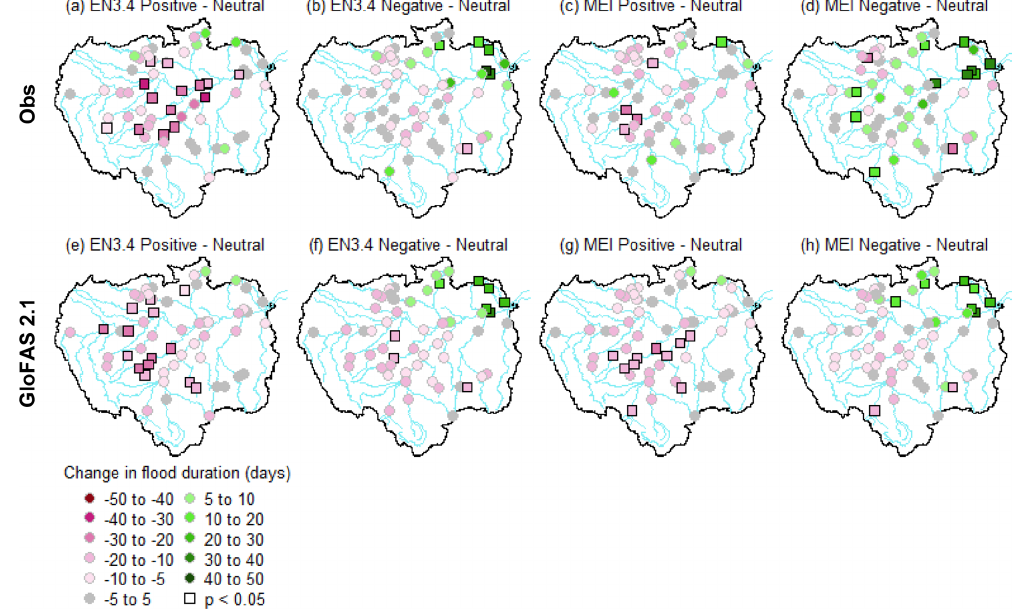
Figure 8. Changes in flood duration (i.e. mean number of days river flows exceed the 95th percentile of each station or grid point climatology) for different phases of the EN3.4 and MEI indices. (a, c, e, g) Positive with respect to neutral years. (b, d, f, h) Negative with respect to neutral years. Panels (a–d) represent changes for observations and panels (e–h) show changes for GloFAS 2.1 streamflow reanalysis data. Pink (green) points represent decreases (increases) in the number of days spent above the 95th percentile compared to neutral conditions. Significant results at the 95% confidence level are denoted using a square (i.e. p < 0 . 05).